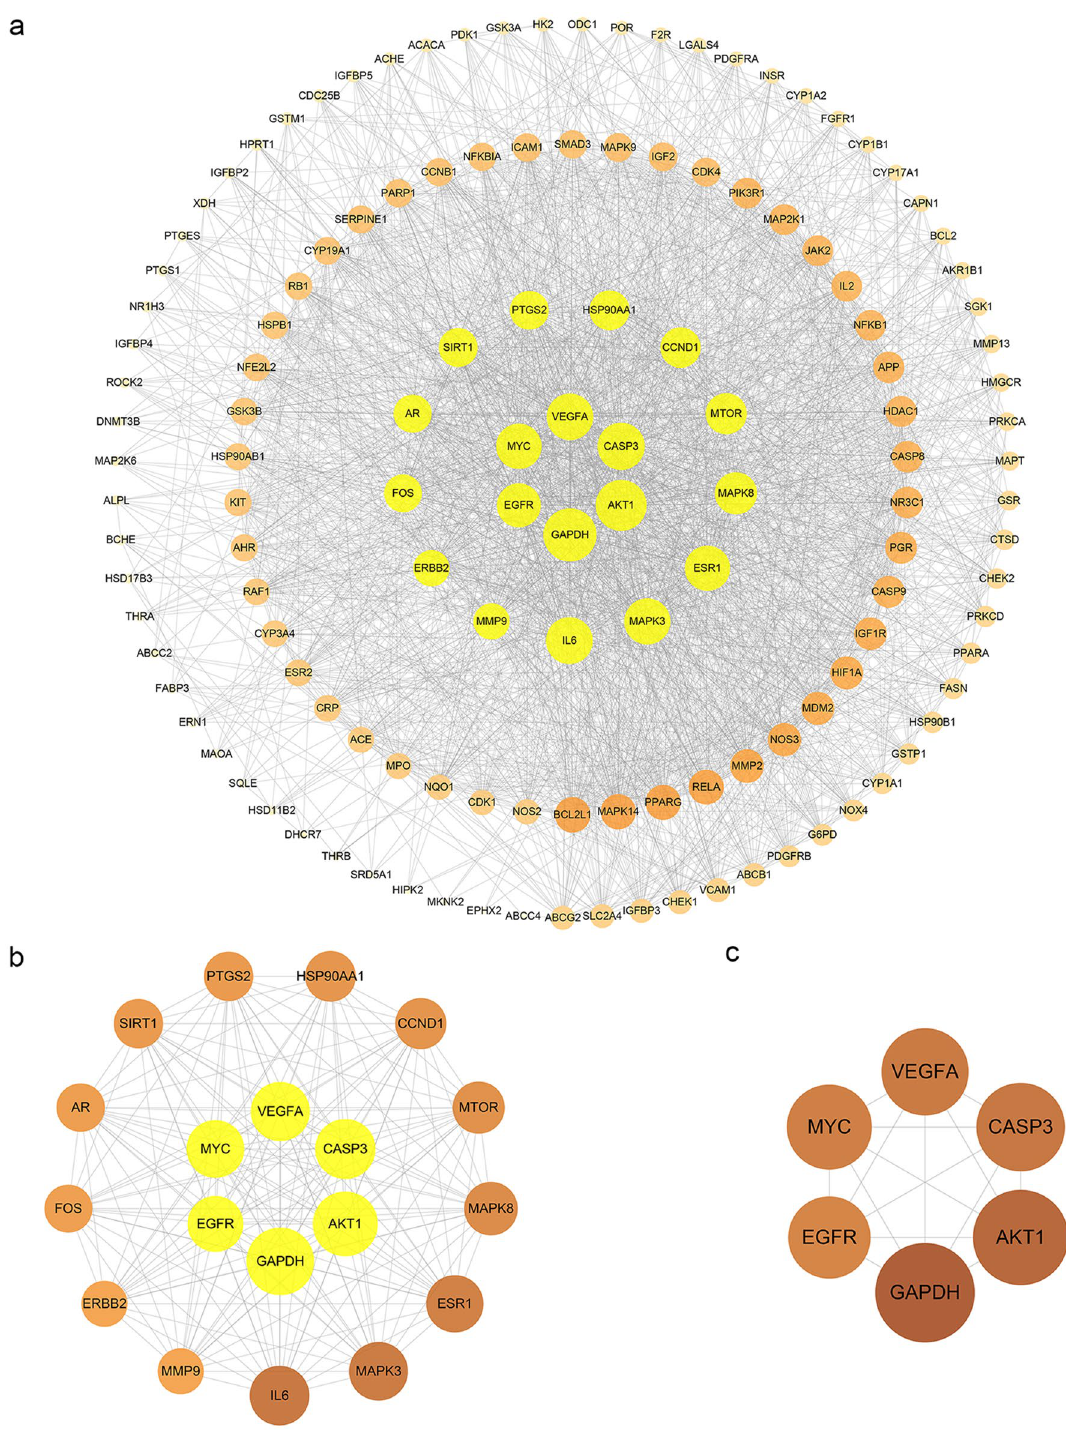
Figure 3. MOLBCH-OA PPI Network and Evaluation. ( a ) MOLBCH-OA PPI network (136 nodes and 2233 edges). ( b ) PPI network by the screening criteria of ‘DC ≥ 58 ′ (19 nodes and 169 edges). ( c ) Core-target PPI network by the screening criteria of “‘DC’ ≥ 75, ‘EC’ ≥ 0.1584286, ‘LAC’ ≥ 33.873016, ‘BC’ ≥ 400.05, ‘CC’ ≥ 0.6818182, ‘NC’ ≥ 62.32288, ‘SC’ ≥ 12,901,748,000,000,000,000, ‘IC’ ≥ 15.5665245” (6 nodes and 15 edges). The nodes stand for the target protein of MOLBCH on OA. The color scales and the size of the circle represent the node degree of the target